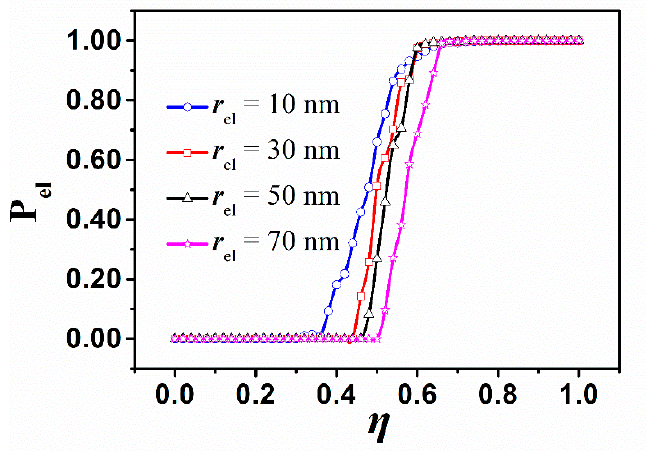
p on the impregnation loading. Figure 6. The dependence of the percolation ratio p el on the impregnation el